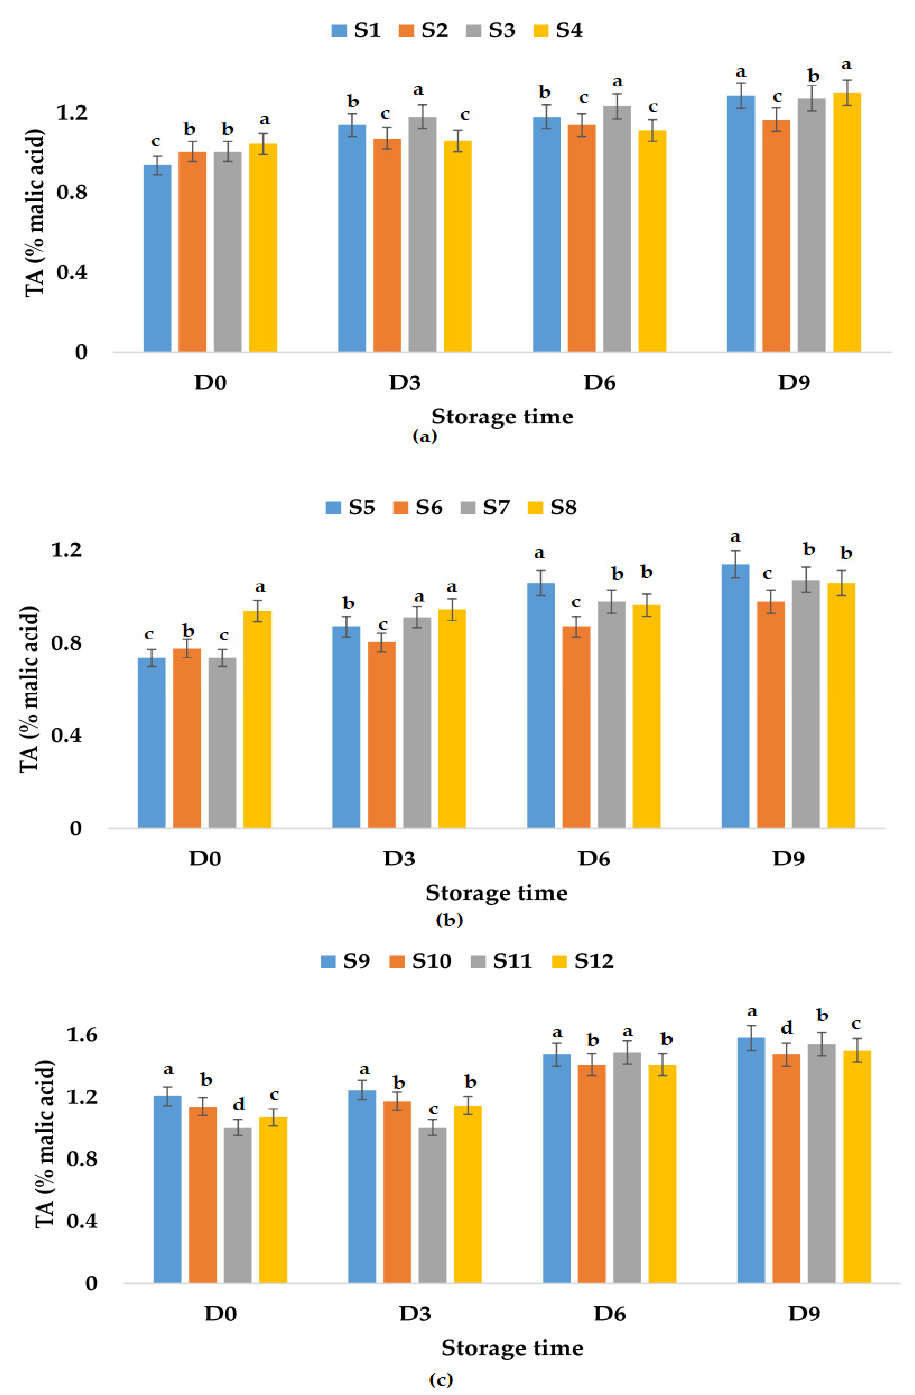
Figure 5. Variation in TA (% malic acid) of juice samples during the storage period (D-day) at refrigeration temperature (4 ◦ C): ( a ) apple juice samples (S1, S2, S3, S4); ( b ) apple and pumpkin juice samples (S5, S6, S7, S8); ( c ) apple and pomegranate juice samples (S9, S10, S11, S12). Means with different lowercase letter indicate the significant differences ( p < 0.05) among the samples and were performed separately for each day of